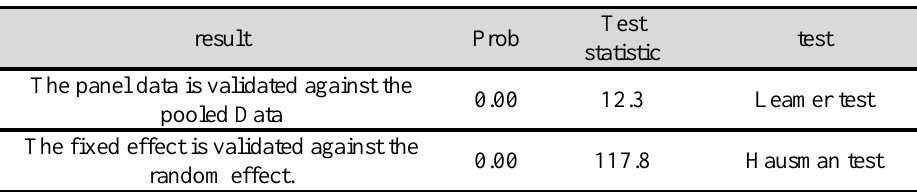
Table 3: Results of Leamer and Hausman tests